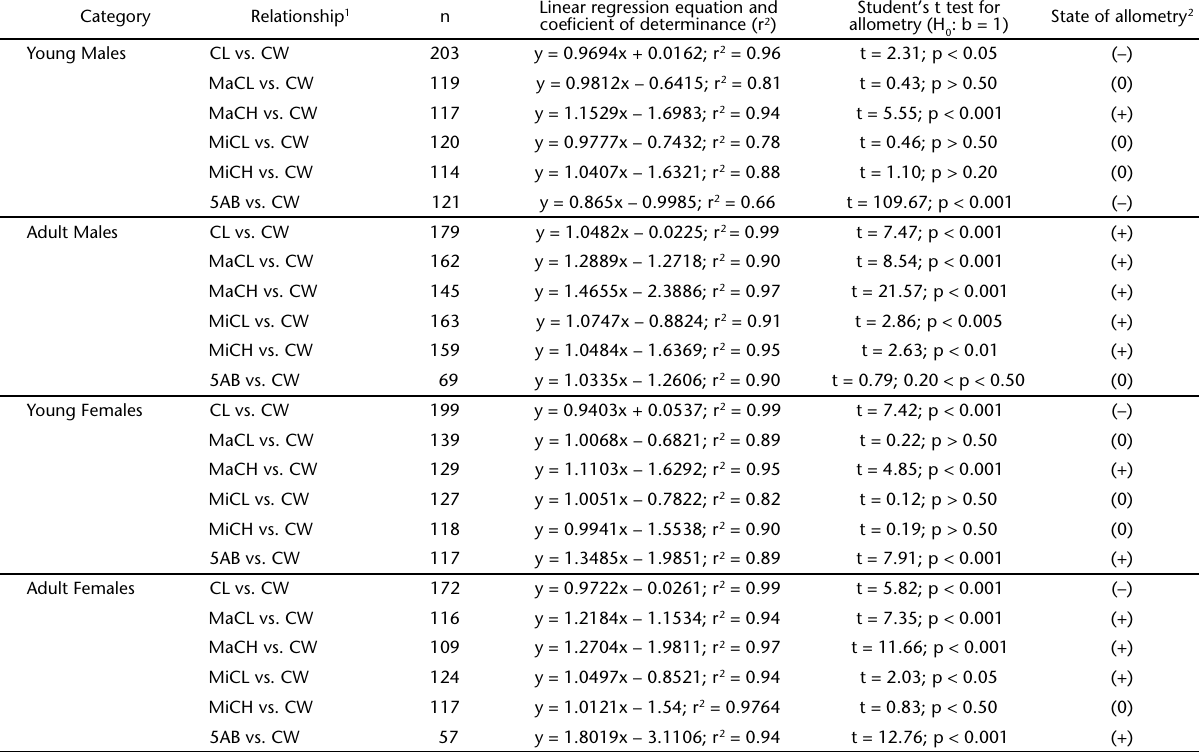
Table I. Trichodactylus fluviatilis . Linear regression parameters and equations, and the state of allometry corresponding to each regression.